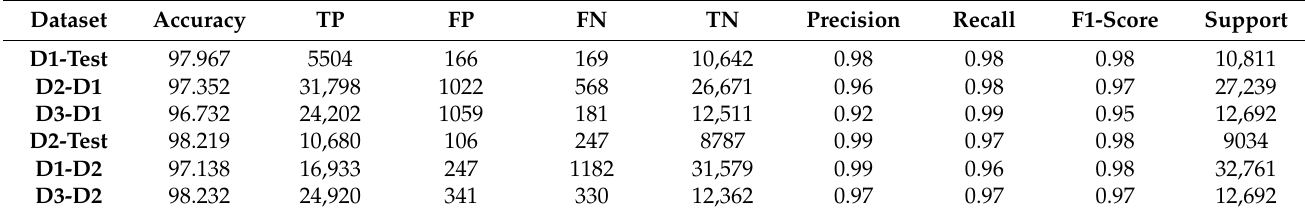
Table 8. Results of Extratree ML model.